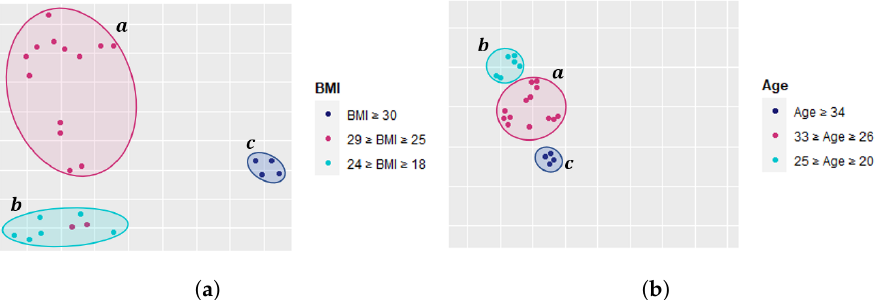
Figure 6. PCA plots showing signs of fatigue captured by the three fatigue-related features and BMI/age. ( a ) BMI perspective. ( b ) Age